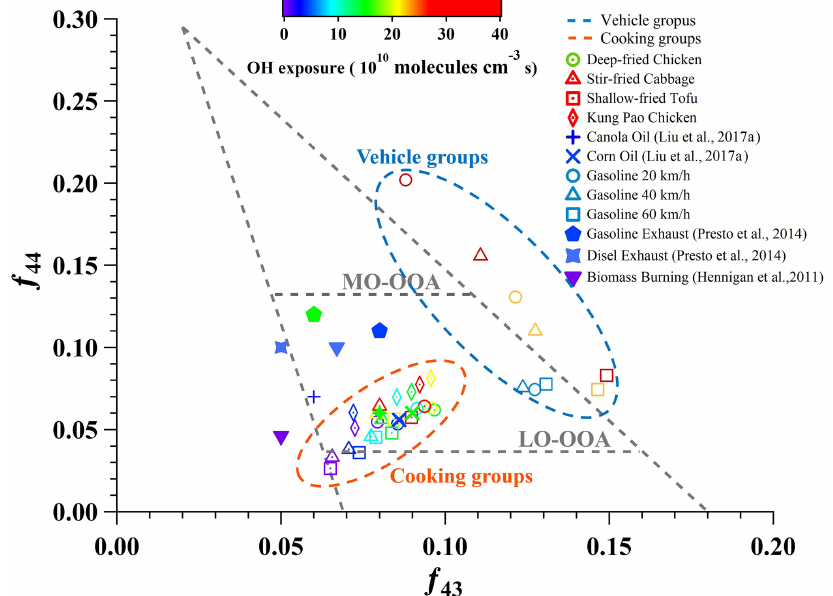
Figure 5. Fractions of entire organic signals at m/z 43 ( f 43 ) vs. m/z 44 ( f 44 ) from various sources as well as an Ng triangle plot. The f 43 and f 44 are determined by an HR-ToF-AMS. The average data at each gradient are shown in the